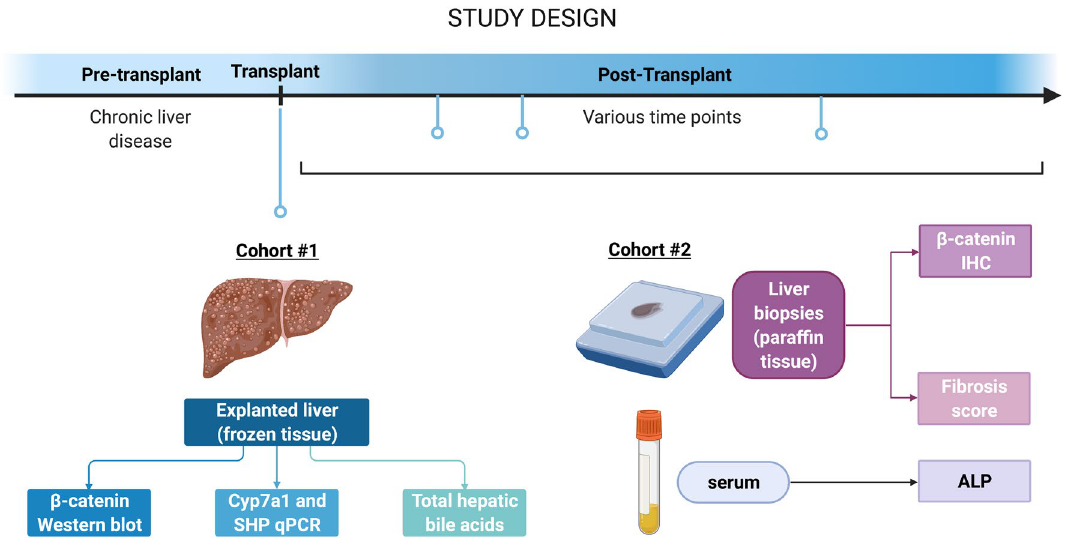
Figure 1. Flow chart of study design. The first cohort (n = 7 normal; n = 18 PSC) consisted of native liver removed at the time of transplant. The second cohort (n = 11 recurrent; n = 10 non-recurrent) consisted of follow-up biopsies (n ≥ 1) from livers post-transplant. Note that the two cohorts are independent of one another, and no information was available regarding patient overlap between the two groups, if